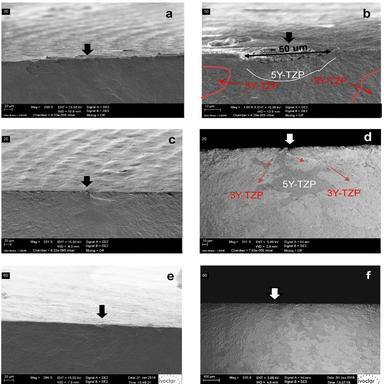
SEM pictures of the fractography analysis of YSZ in water at different stress rates: a, b) 100 MPa/s and fracture strength f = 412 MPa. c, d) 100 MPa/s and fracture strength f = 485 MPa. e, f) 0.1 MPa/s and fracture strength f = 402 MPa.